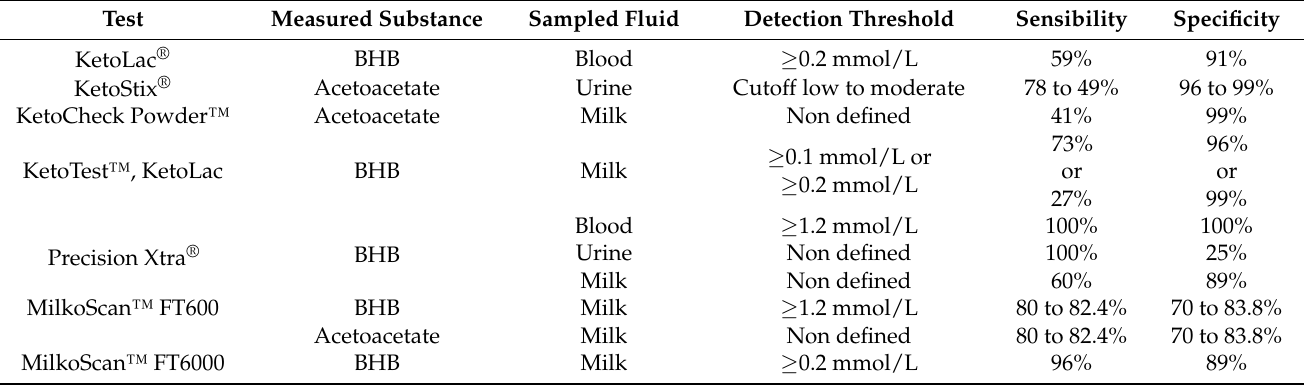
Table 5. Summary table of the characteristics of some ketosis tests (adapted from